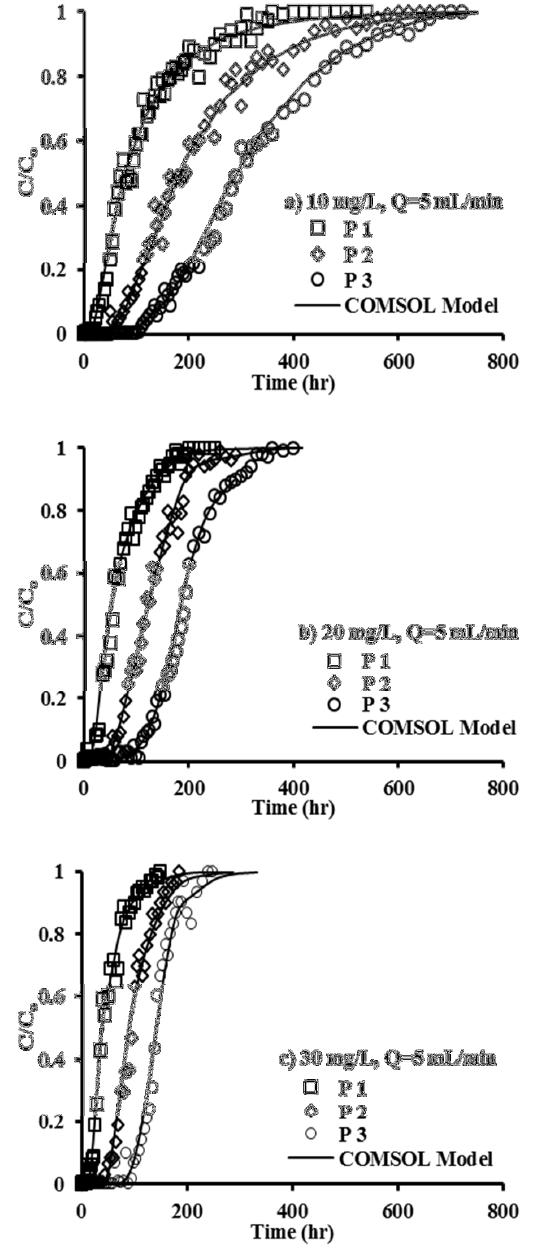
Fig. 5. Comparison between model predictions and experimental measurements for normalized concentration of copper under the effects of initial concentration and bed